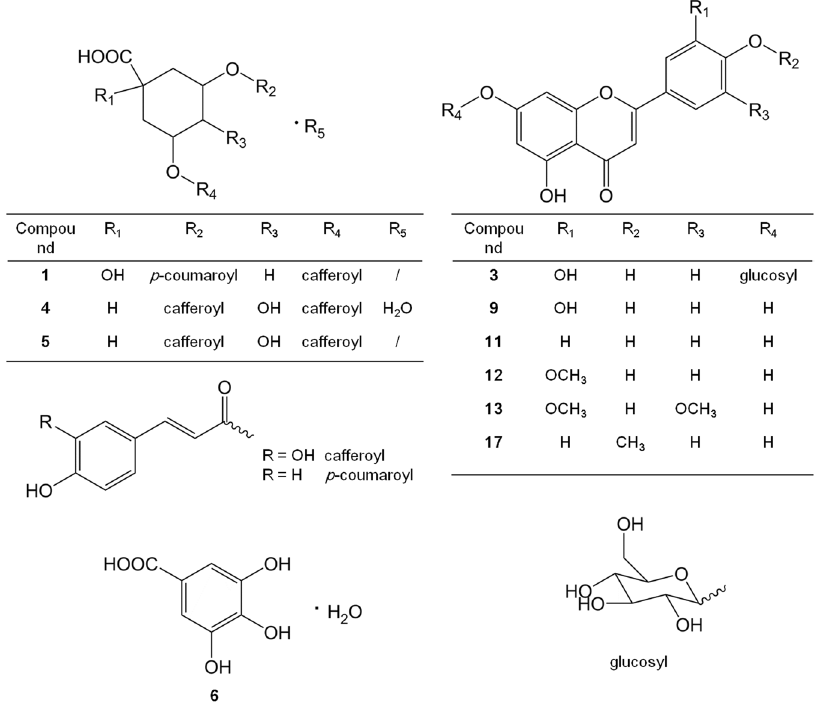
Figure 5. Definable chemical structures of identified phenolic compounds in D . indicum var. aromaticum